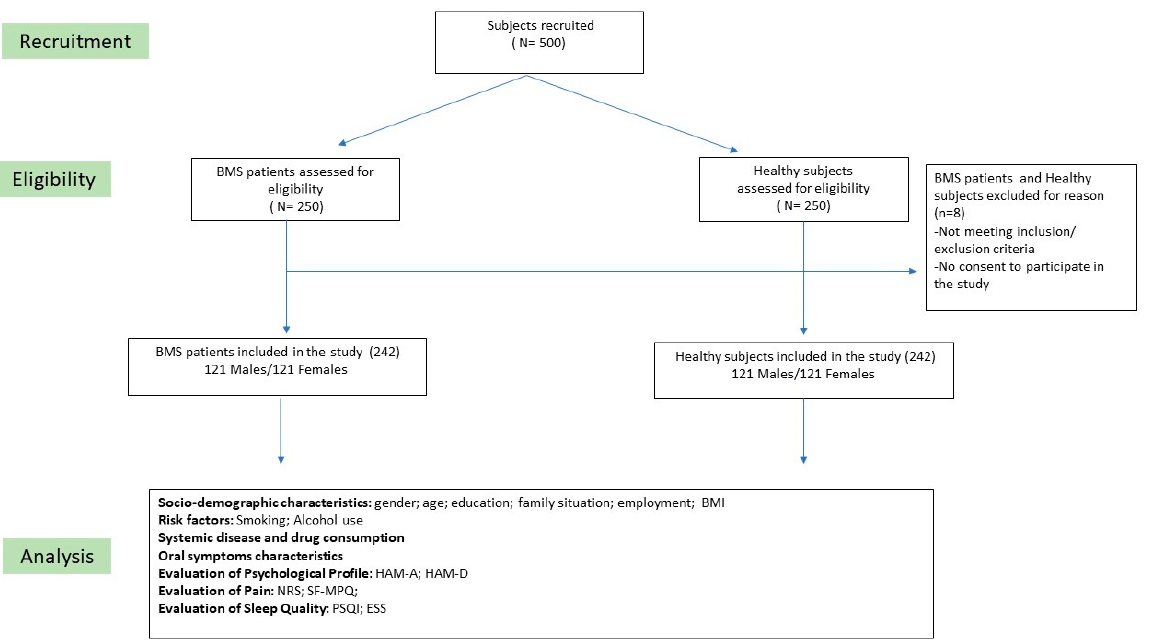
Figure 1. Flow Chart of the study; Abbreviations: BMS: burning mouth syndrome; BMI: body mass index; HAM-A: Hamilton rating scale for anxiety; HAM-D: Hamilton rating scale for depression; NRS: numeric rating scale; SF-MPQ: short-form Mc-Gill pain questionnaire; PSQI: Pittsburgh sleep quality index; ESS: Epworth sleepiness